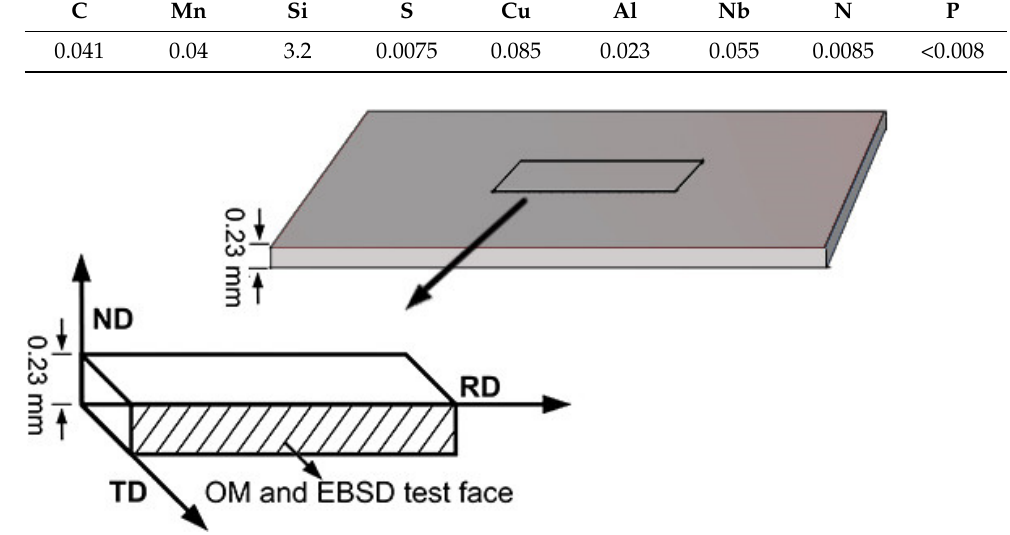
Table 1. Chemical compositions of grain-oriented silicon steel (wt.%).